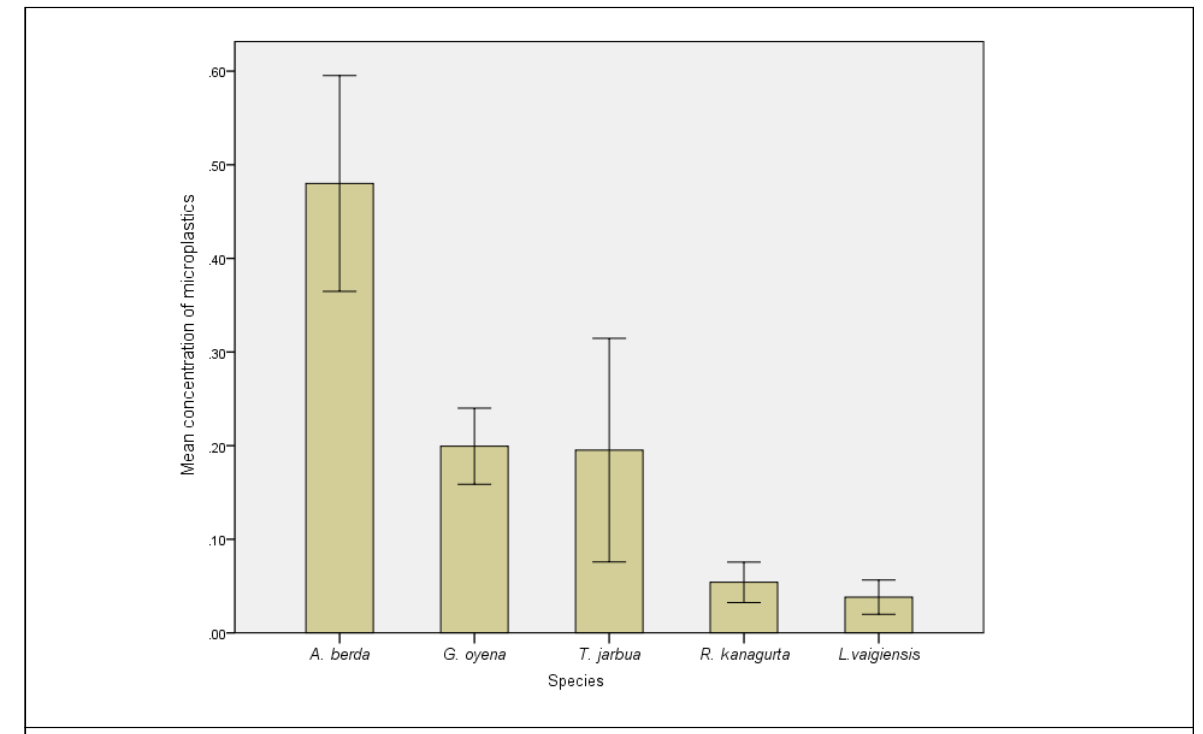
Figure 3: Mean (± SE) microplastics concentrations for the different fish species with standard error bars (MPs per gram)